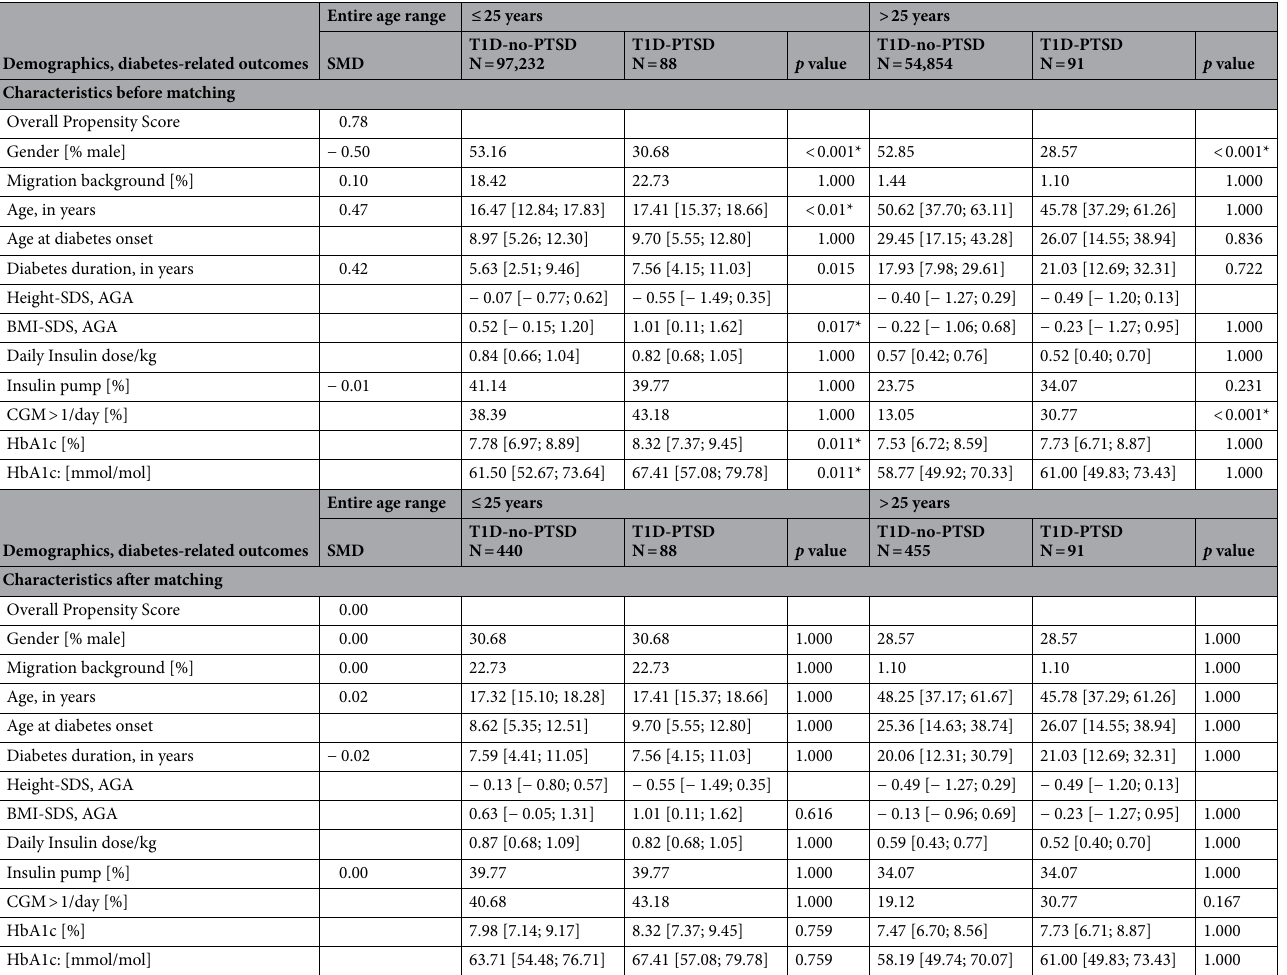
Table 2. Baseline characteristics of patients with T1D (for age ≤ 25, > 25 years) before and after matching (variables: age, gender, diabetes duration, type of insulin treatment and migration background), comparing patients with T1D and comorbid PTSD to patients with T1D without PTSD. All data are presented in median [Q1; Q3] or percentage [%]. Entire age range = Total age range of patients in the T1D + PTSD group and T1D- only group. SMD standardized mean difference between T1D-no-PTSD and T1D + PTSD group, T1D type 1 diabetes, PTSD posttraumatic stress disorder, T1D-no-PTSD patients with T1D without PTSD, with or without other comorbid mental disorder, T1D + PTSD patients with T1D and PTSD, with or without other mental comorbidity, BMI body-mass index, SDS standard deviation score, AGA Arbeitsgemeinschaft Adipositas im Kindes- und Jugendalter, CGM continuous glucose monitoring, HbA1c Hemoglobin A1c. *Significant (p <